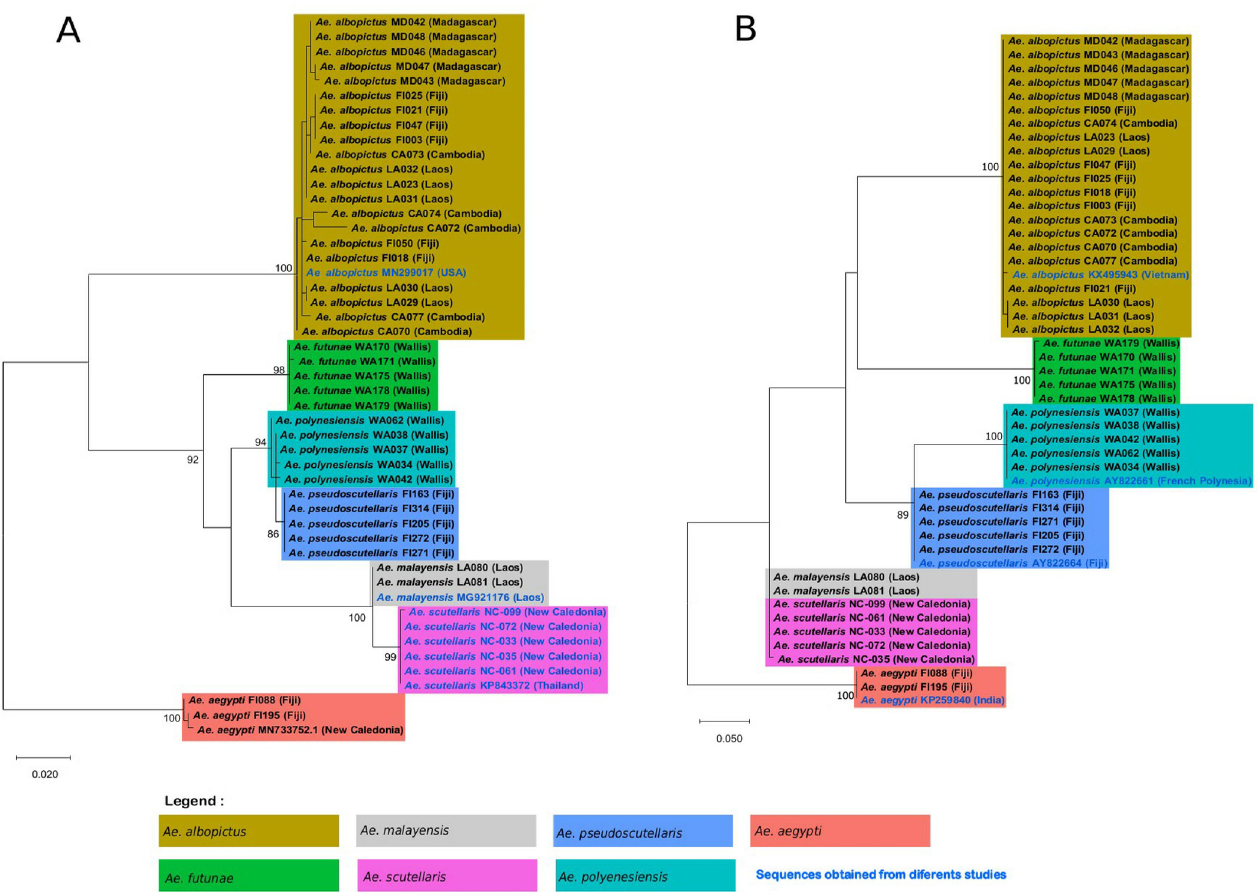
Fig 4. Maximum likelihood evolutionary (MLE) relationships of mosquito species of the Scutellaris Group. A—Maximum likelihood tree derived from 49 cox 1 nucleotide sequences. Forty sequences generated during the current study (in black), six sequences generated during our previous study and deposited in the GenBank database (in black) [29] and three sequences retrieved from the GenBank database (in blue). B—Maximum likelihood tree derived from 49 ITS2 nucleotide sequences. Forty-five sequences were generated during this study (in black) and four sequences were retrieved from the GenBank database (in blue). For all analyses, the percentage of replicate trees in which the associated taxa clustered together in the bootstrap test (1000 replicates) is shown for values over 80. The country of collection is indicated along with the specimen number. Colors indicate mosquito